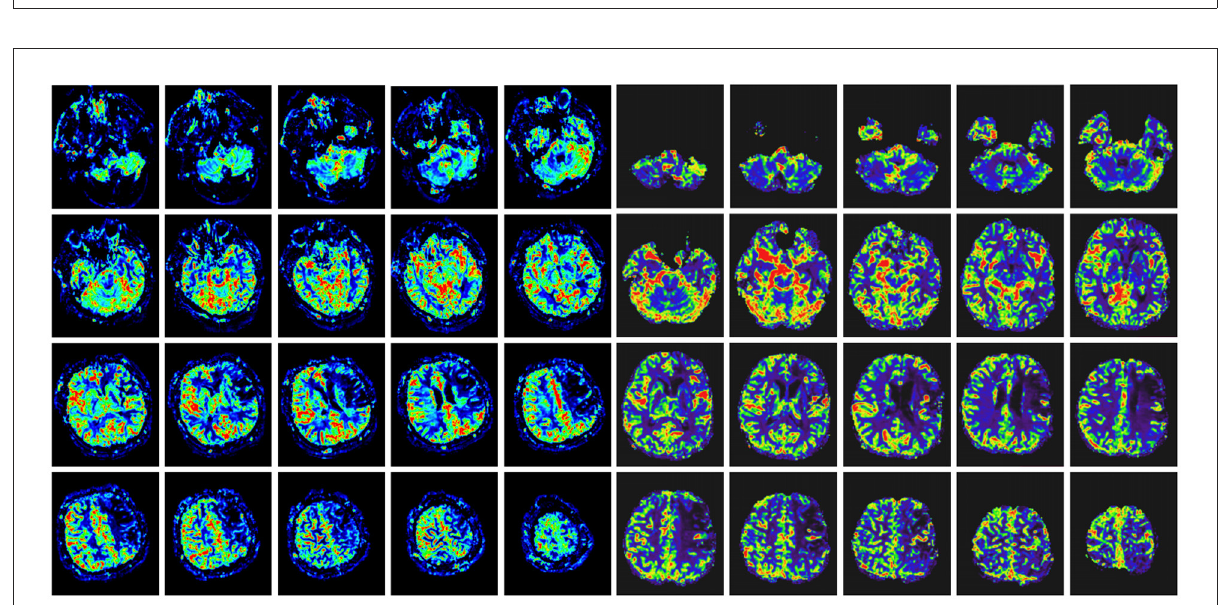
FIGURE3 Comparison of head MRI perfusion before surgery (left) and after surgery (right) in the same patient with Figure 2. The preoperative ischemic region had improved perfusion in the same region after indirect bypass surgery.